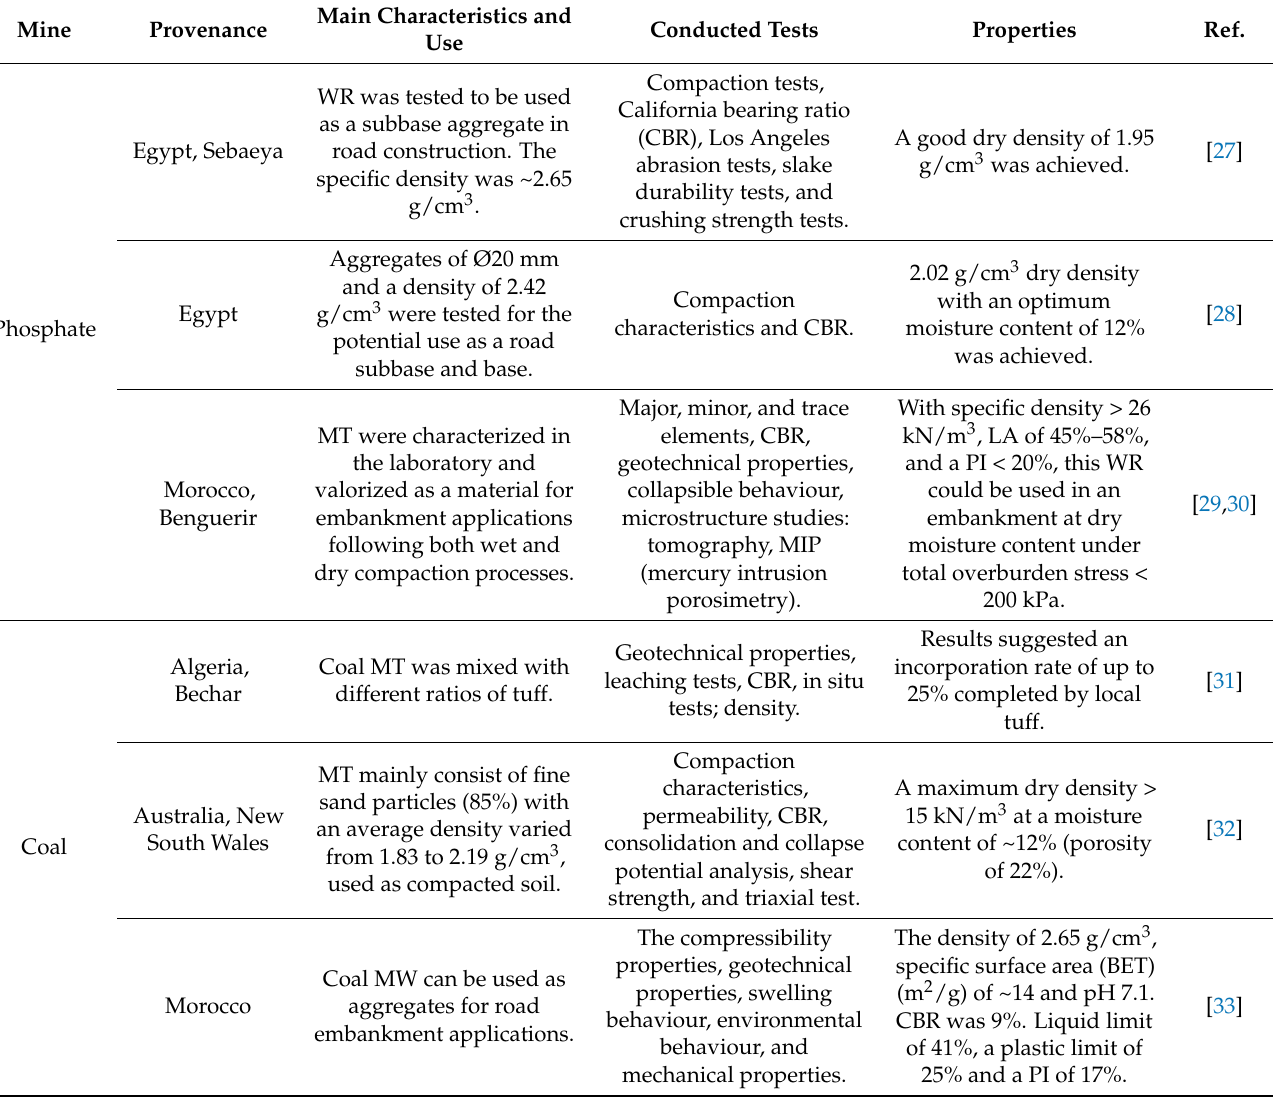
Table 2. Mine wastes used in road